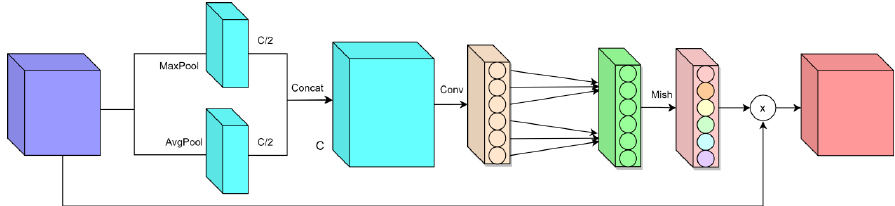
Figure 6. MECA Attention